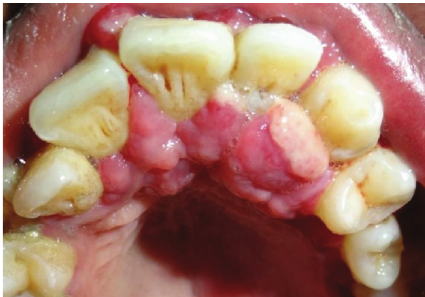
Figure 2: Intraoral view showing unilateral palatal overgrowth.